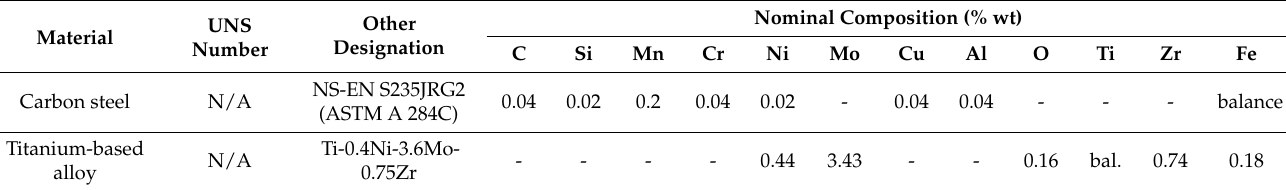
Table 4. Chemical composition of the testing materials.